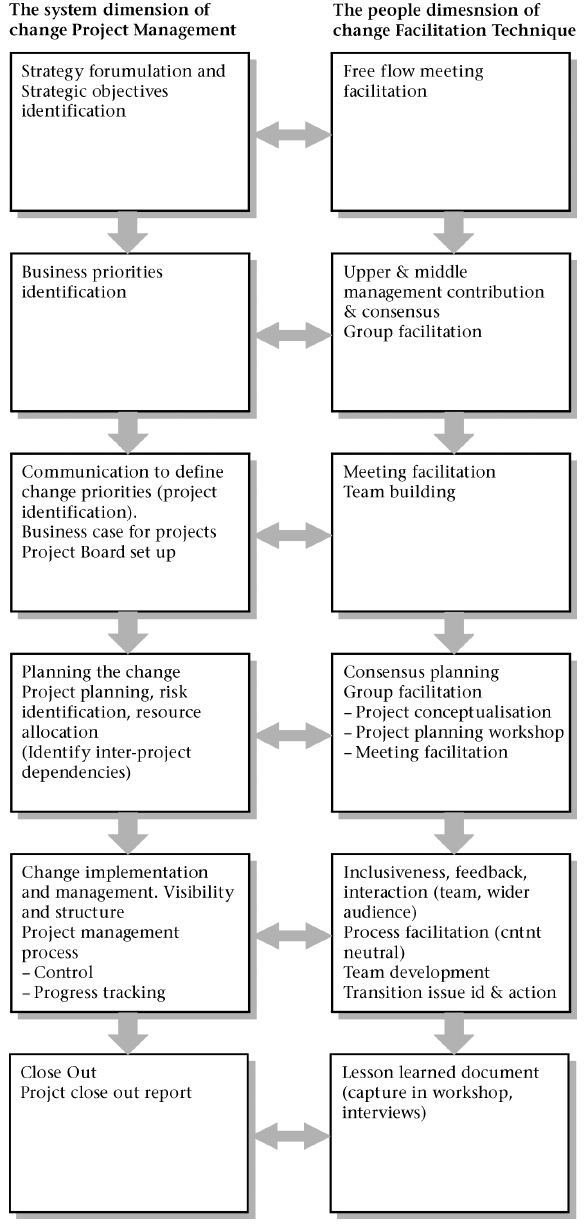
Figure 5: The facilitative project mangement